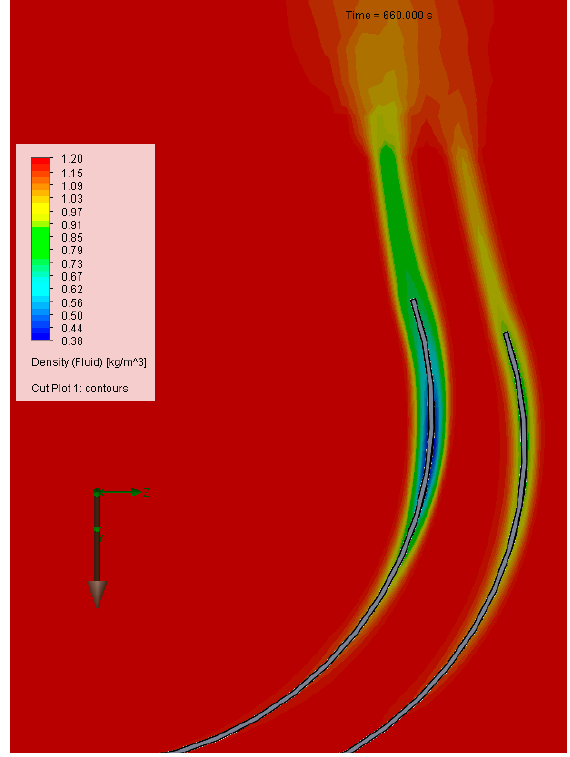
Figure 28. Air density at 660 s.